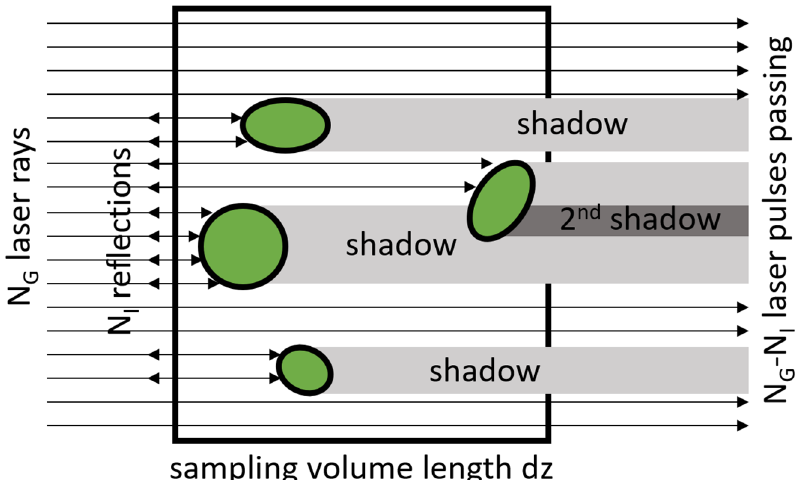
Figure 3. Sketch of a single sampling volume completely covered by many test beams approaching from the left side and hitting some vegetation parts, drawn in green.